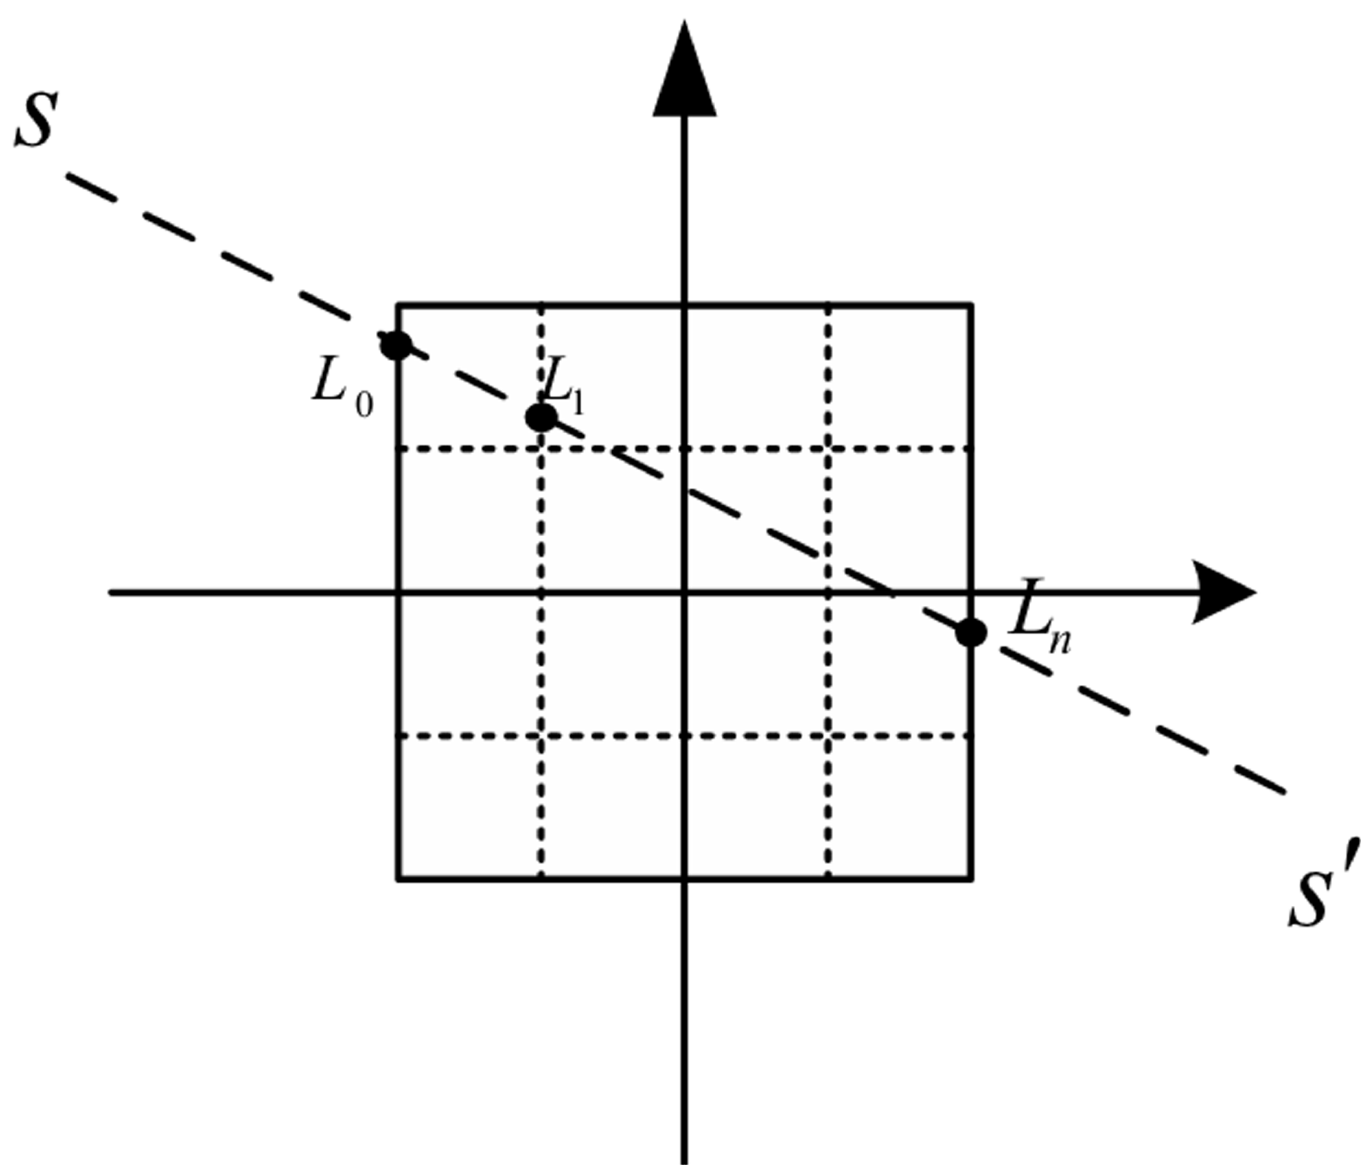
Fig 3. Geometrical relationship between a ray and an